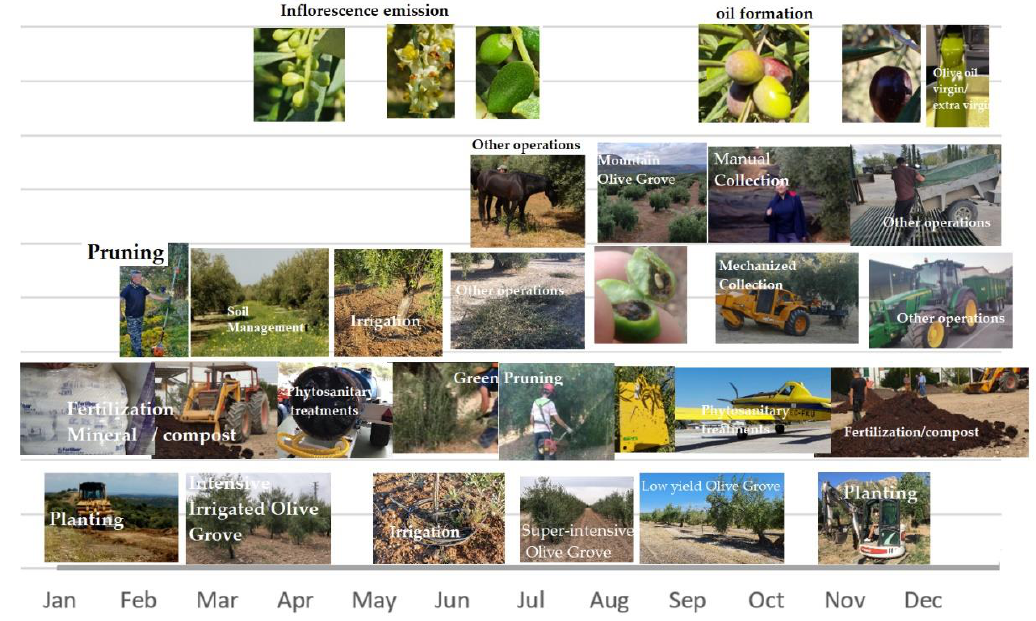
Figure 2. Agricultural tasks during a year (olive grove). Also, cultivation systems.